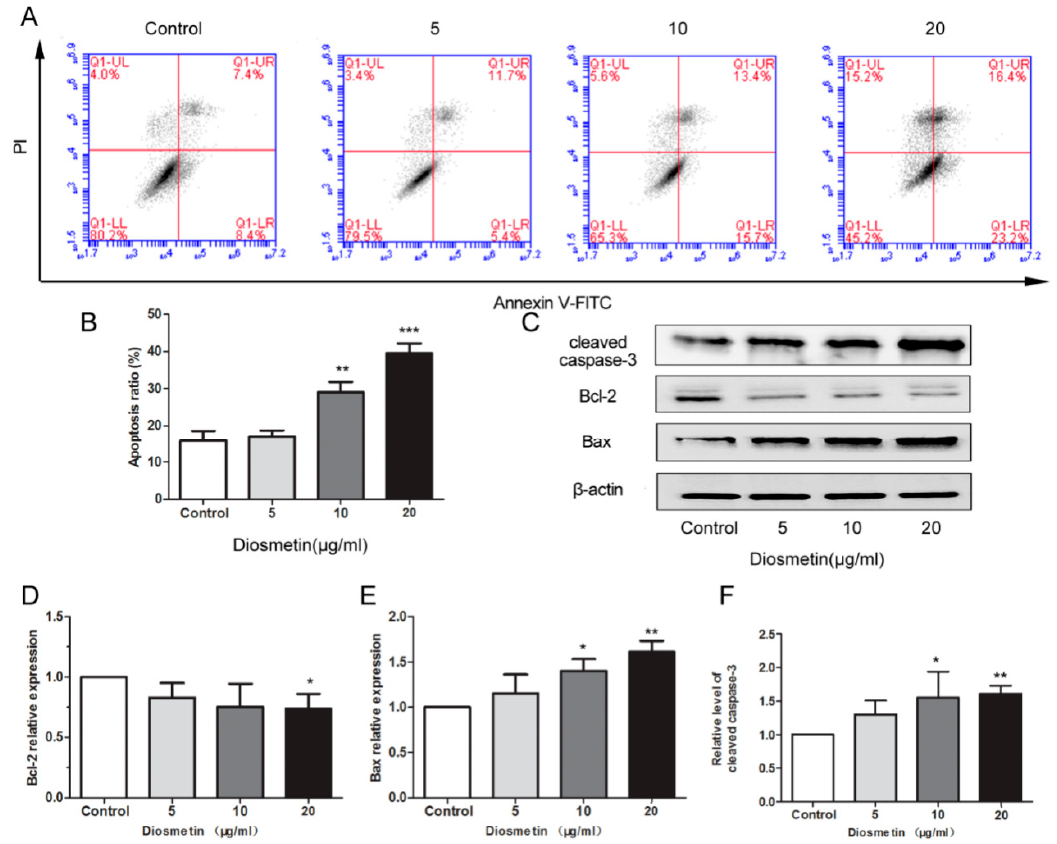
Figure 3. Diosmetin induced the apoptosis of glioma cells. ( A , B ) Flow cytometry analysis